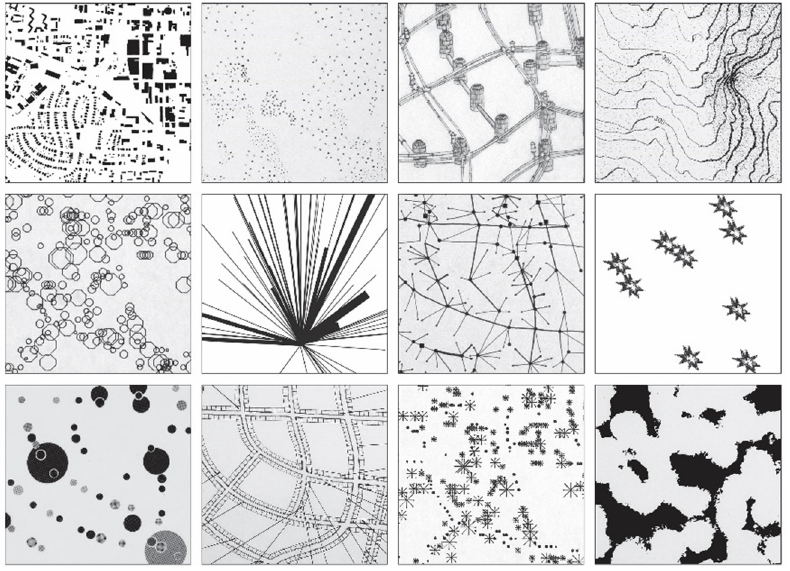
Figure 4. Back endpaper of Everything Sings ([5], used with permission).